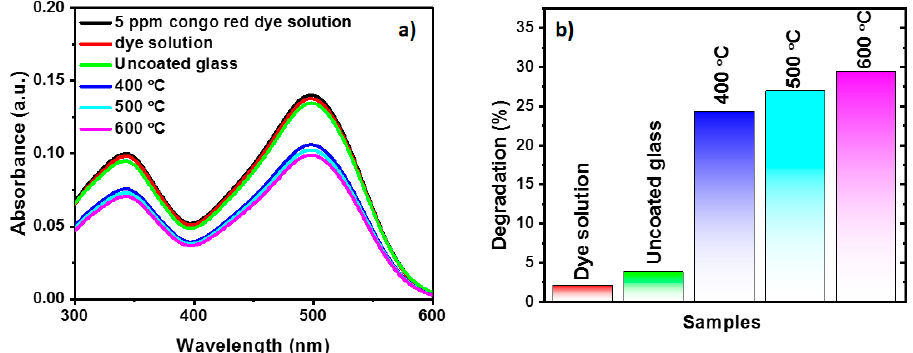
Figure 8. Photocatalytic activity of TiO 2 thin-film coated glass post-annealed at different temperature ( a ) Congo-red absorbance, ( b ) percentage of degradation.